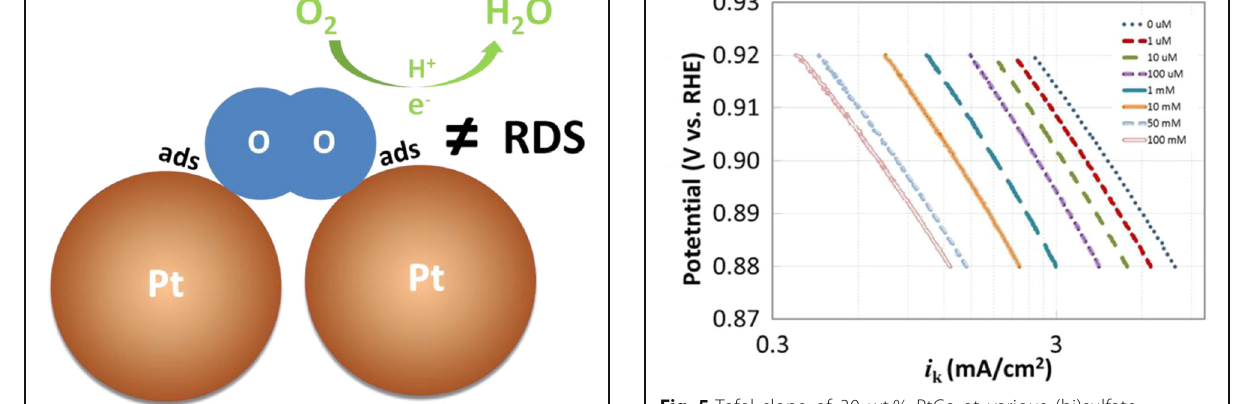
Fig. 5 Tafel slope of 30 wt.% PtCo at various (bi)sulfate ion